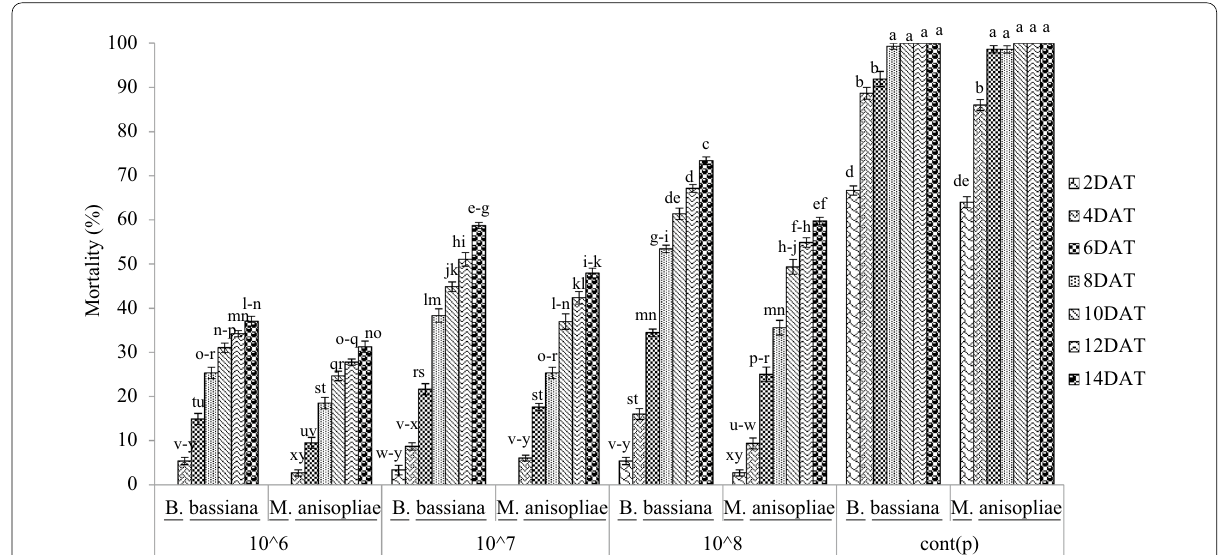
Fig. 1 Contact pathogenicity of Beauveria bassiana and Metarhizium anisopliae against Bactrocera cucurbitae at three concentrations (10 6 , 10 7 and 10 8 CFU/ml)